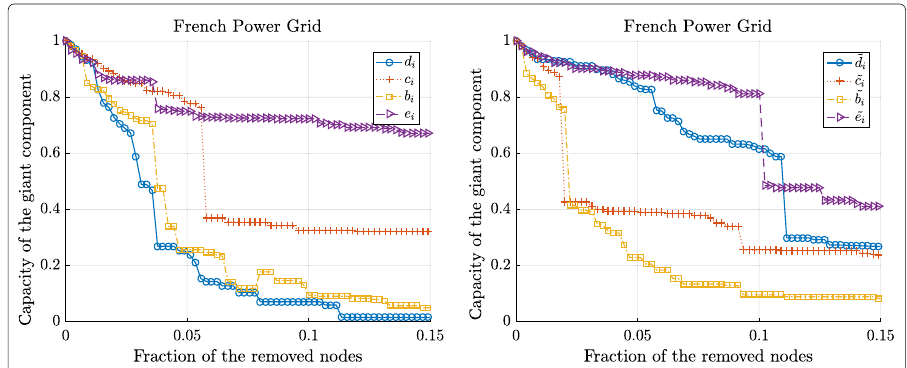
Fig. 8 The normalized capacity of the giant component in the French power grids versus the removal of nodes according to the standard centrality metrics (left) and the extended centrality metrics (right). Nodes are removed sequentially according to the initial values of the centrality